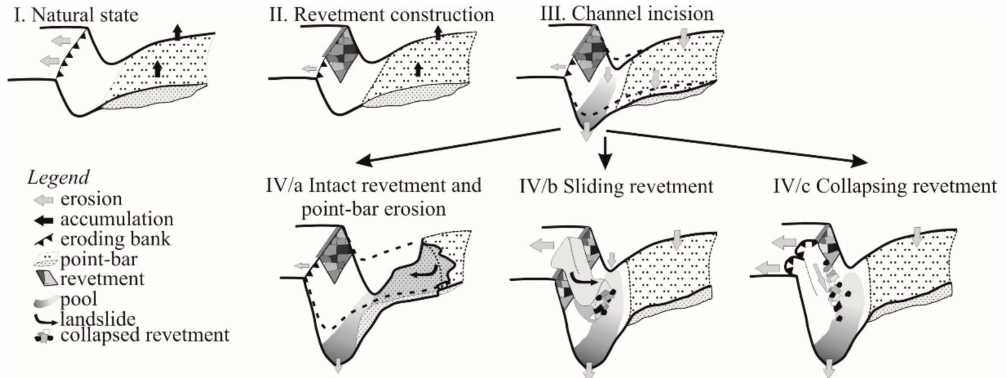
Figure 12. Conceptual model of bank erosion and revetment collapse in the Lower